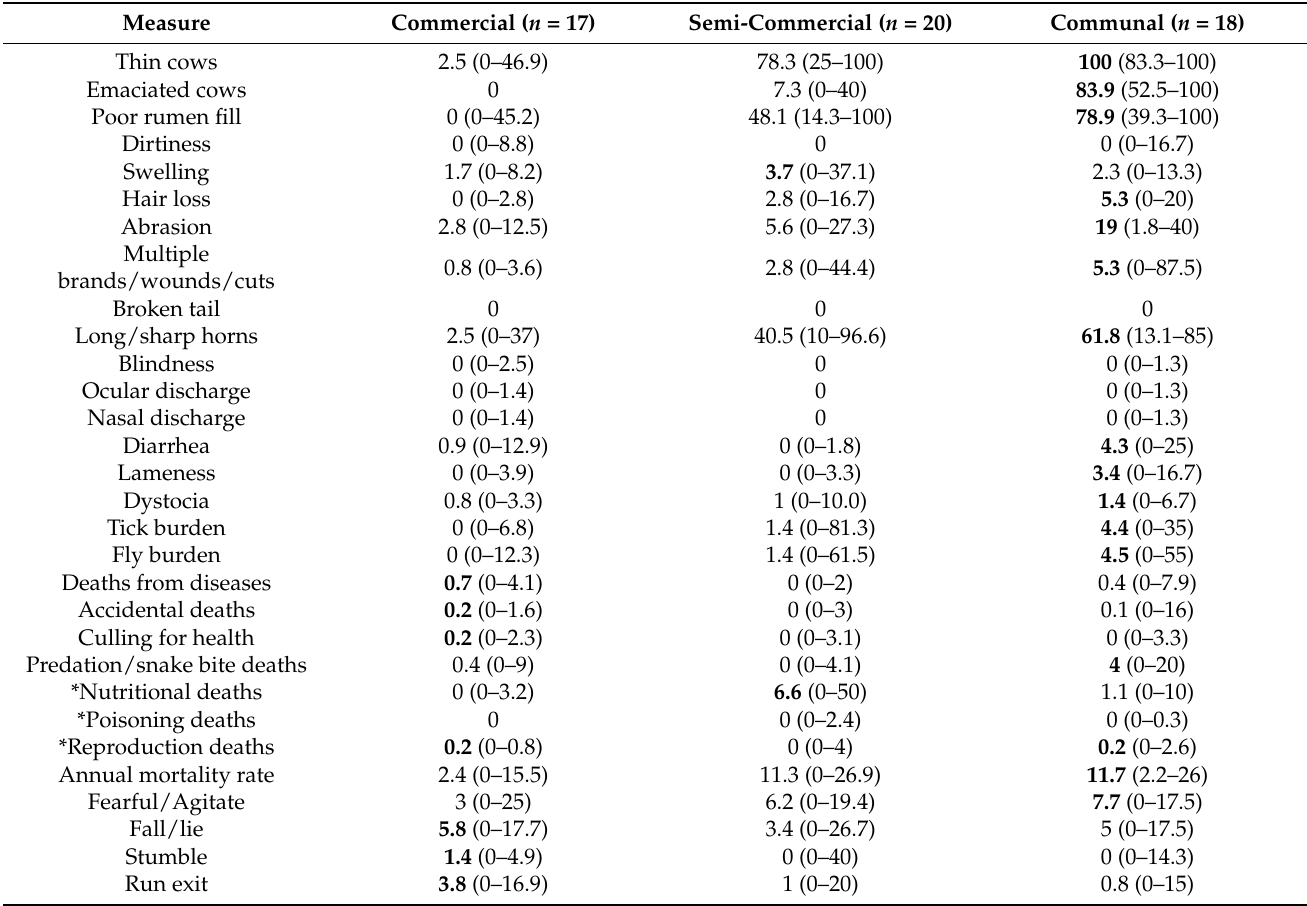
Table 2. Descriptive analysis (median and range in percentage) of continuous welfare indicators in three Namibian beef production systems.